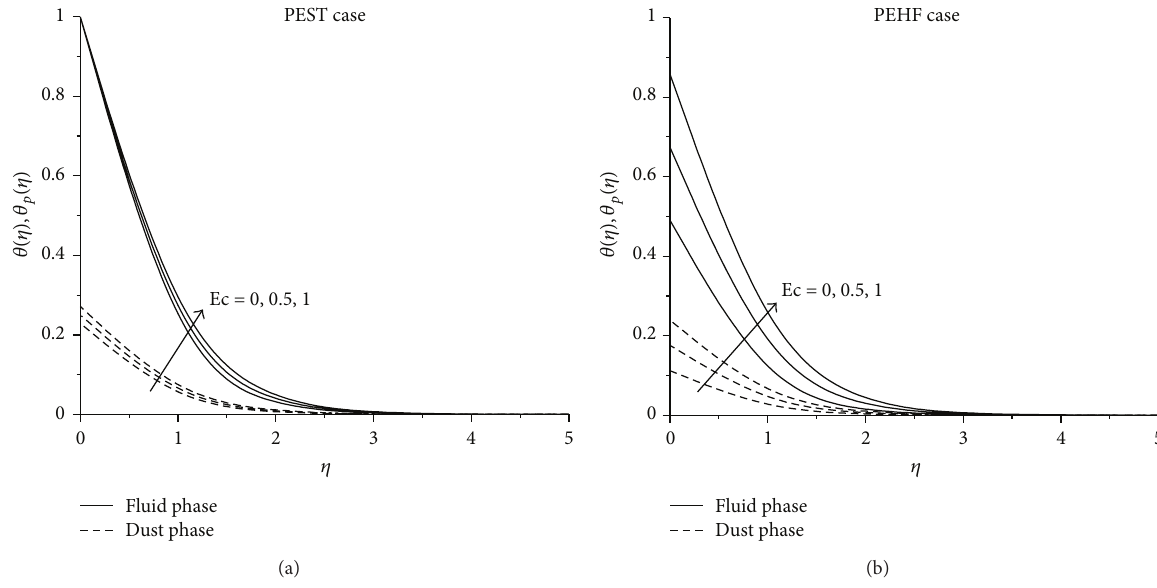
Figure 9: Effect of Ec on temperature profiles for both PEST and PEHF cases with 𝑆 = 𝑁 = 𝜆 = 0.5 , Pr = 0.72 , and 𝛽 = 0.6 .